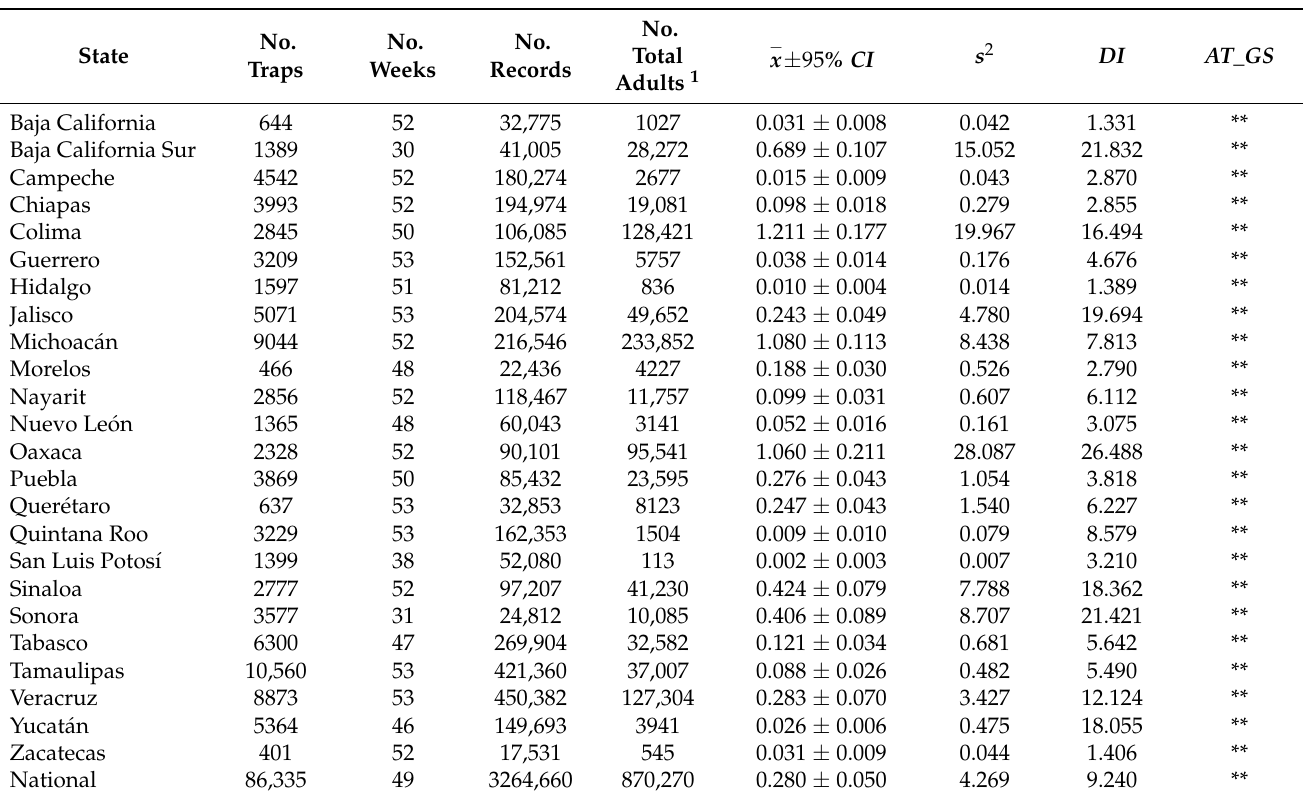
Table 1. Exploratory analysis of the number of Diaphorina citri adults captured per week and per tree in the Mexican citriculture during the 2015 annual monitoring